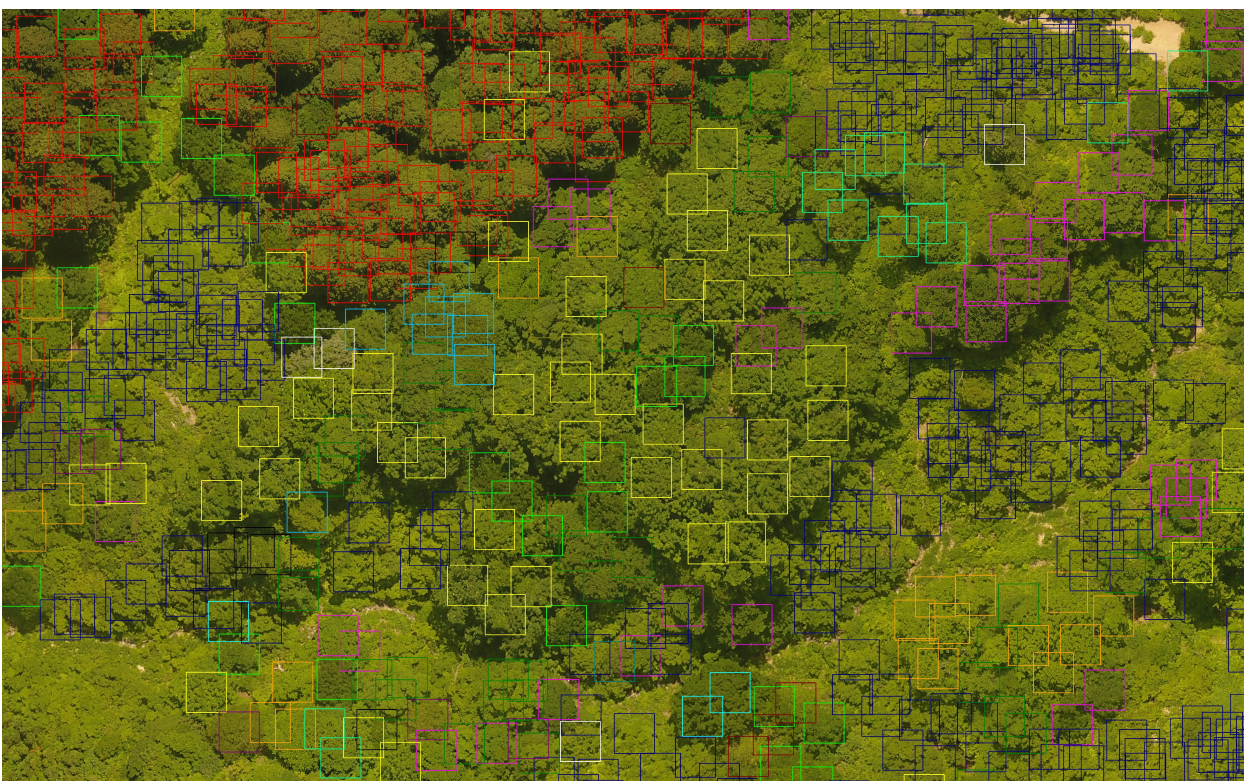
Figure 5. Overview of the two approaches reviewed in this section.